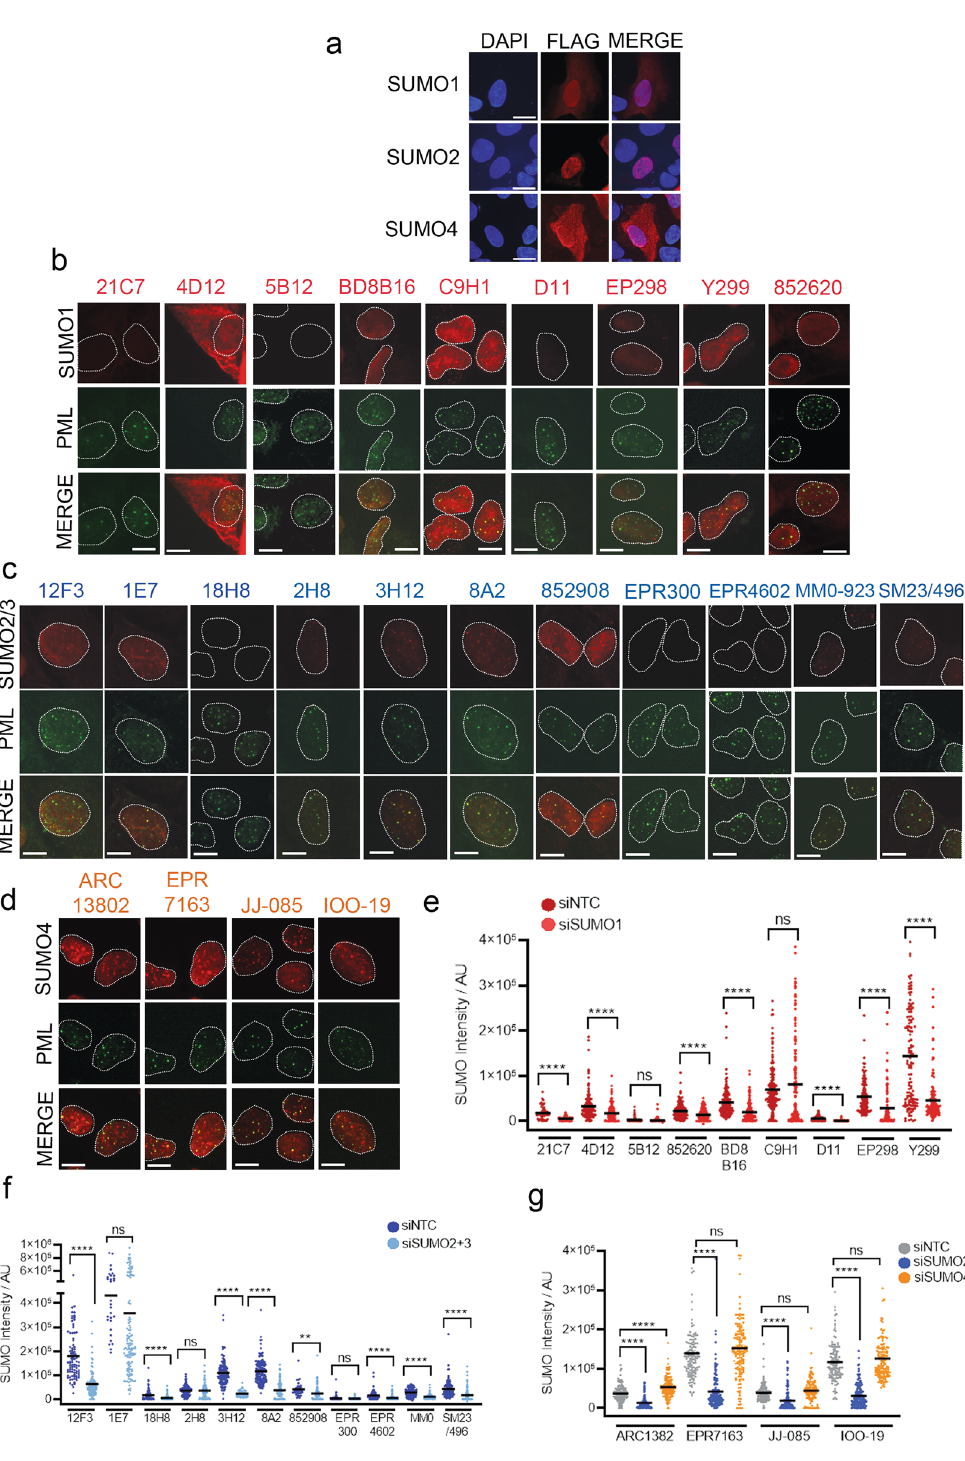
Figure 5. SUMO MAbs as detection tools for subcellar microscopy. (a) Detection of exogenous FLAG-SUMO1, FLAG- SUMO2 and FLAG-HA SUMO4 in U2OS by indirect immunofluorescence using anti-FLAG antibodies. Scale bar = 10 µm. ( b) U2OS cells stained with indicated anti-SUMO1 MAb (red) and PML (green). Mouse and Rat SUMO1 MAbs (21C7, 4D12, 5B12, BD8B16, D11 and 852620) were co-stained with Rabbit PML antibody and Rabbit SUMO1 MAbs were co-stained with Mouse PML antibody. Scale bar = 10 µm. To improve visibility brightness was increased by 20% across all panels. ( c) Cells stained as for ( b ), using anti-SUMO2/3 MAbs. To improve visibility brightness was increased by 20% across all panels. ( d) Cells stained as for ( b ) using anti-SUMO4 MAbs. ( e) Quantification of SUMO1 MAb intensity signal per whole cell treated with either control (siNTC) or SUMO1 (siSUMO1) siRNA for 72 h prior to fixation. Two-tailed t-test denotes statistical differences between siNTC and siSUMO1. N = ~ 100 cells per condition. ( f) Quantification of the anti-SUMO2/3 MAb signals in the presence and absence of SUMO2 + 3 siRNA. N = ~ 100 cells per condition. ( g) Quantification of the anti-SUMO4 MAb signals in the presence and absence of SUMO2 + 3 and SUMO4 siRNA. N = ~ 100 cells per